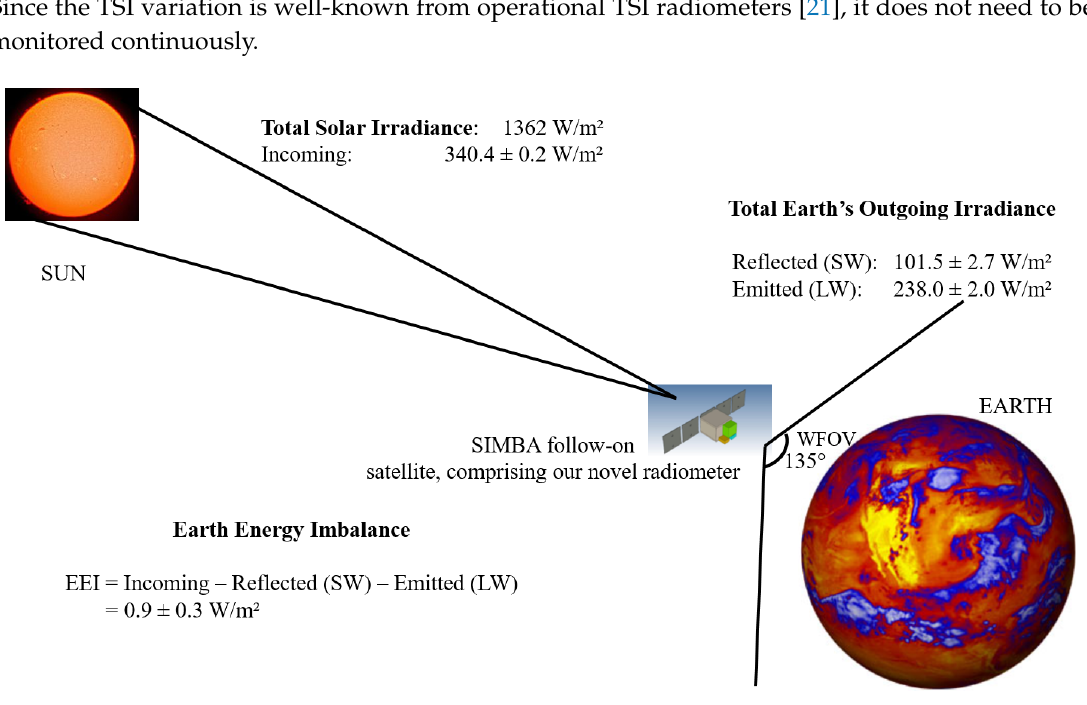
Figure 1. Earth viewed by the wide field-of-view (WFOV) radiometer. Occasional Solar pointing will allow intercalibrating the Incoming Solar Radiation and the Earth’s Total Outgoing Radiation measurements. SW stands for shortwave and LW for longwave. Values for the irradiances are derived from